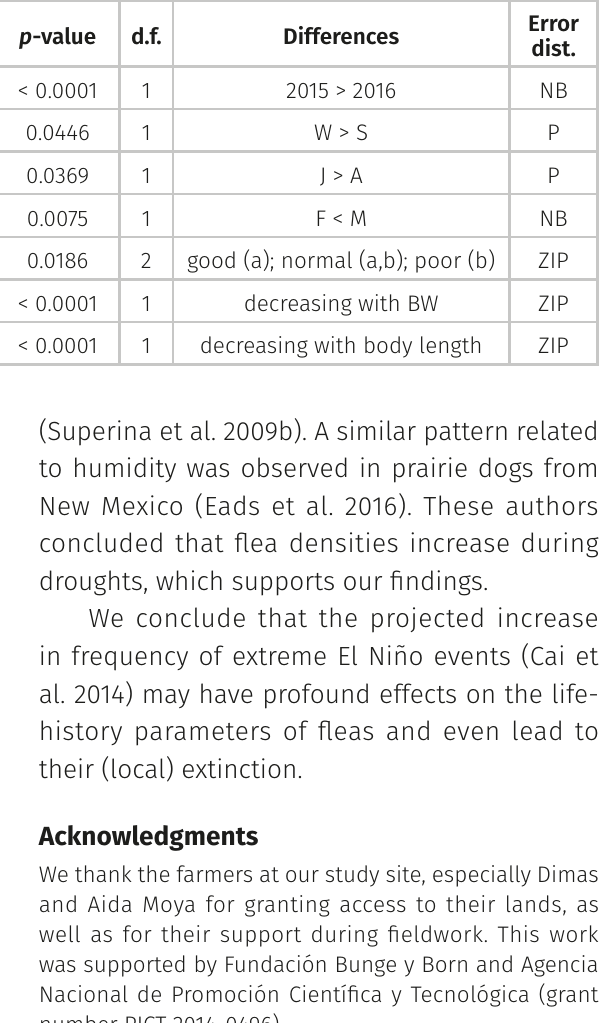
Table IV. Statistical parameters of GLM of intensities versus host-related factors (age, sex, weight, size and physical condition) and environment-related variables (season and year) in Zaedyus pichiy from Mendoza,